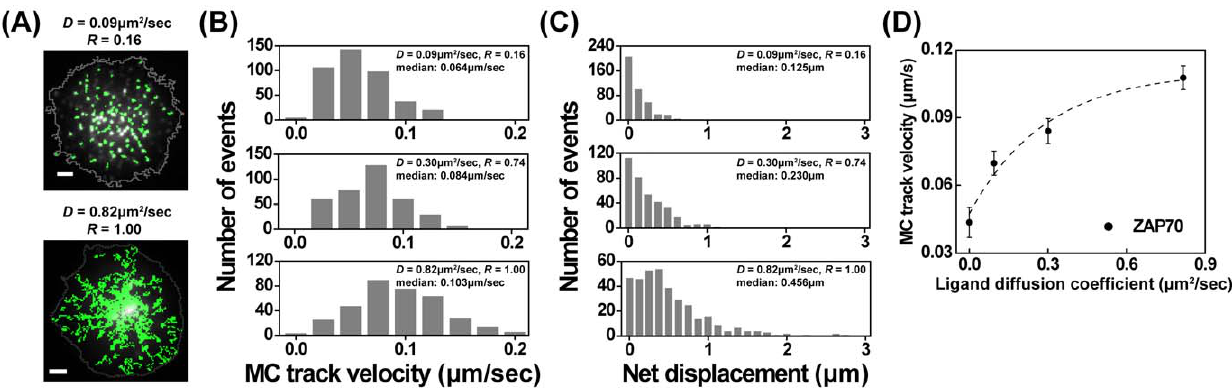
Figure 4. Ligand mobility modulates ZAP70 MC translocation in primary mouse T cells. CD4 + mouse T cell blasts were transduced with GFP-ZAP70, and imaged by TIRF microscopy while interacting with 2C11-coated bilayer surfaces with different ligand mobility. (A) Representative images showing tracking of MC trajectories (green). Cell boundaries are depicted as gray lines. Scale bars=2 m m. (B,C) Histogram analysis of MC track velocity (B) and net displacement (C) on stimulatory bilayer surfaces with indicated D and R . (D) Average MC track velocity plotted as a function of ligand diffusion coefficient. Dashed line is sigmoidal curve fit to guide the eye. N . 5 cells per condition.